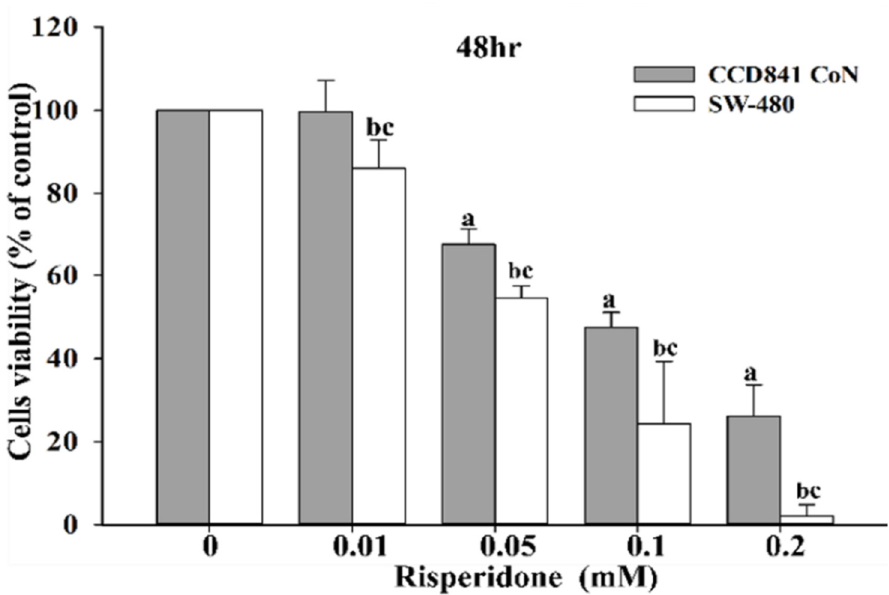
Figure 2. Survival of SW480 cells in the presence of risperidone. “a” indicates a significant di ff erence compared with CCD 841CoN (0 mM). “b” indicates a significant di ff erence compared with SW480 (0 mM). “c” indicates a significant di ff erence between CCD 841CoN and SW480. The superscript letters “a,” “b,” and “c” indicate significant di ff erences ( p < 0.05). Similar results were obtained in three to six repeated experiments.